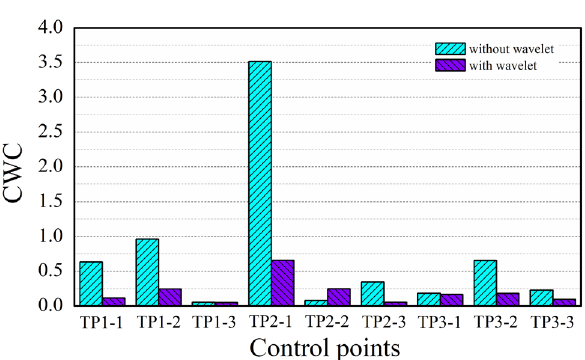
Figure 7. Comparison of the CWC values of PIs before and after wavelet analysis.